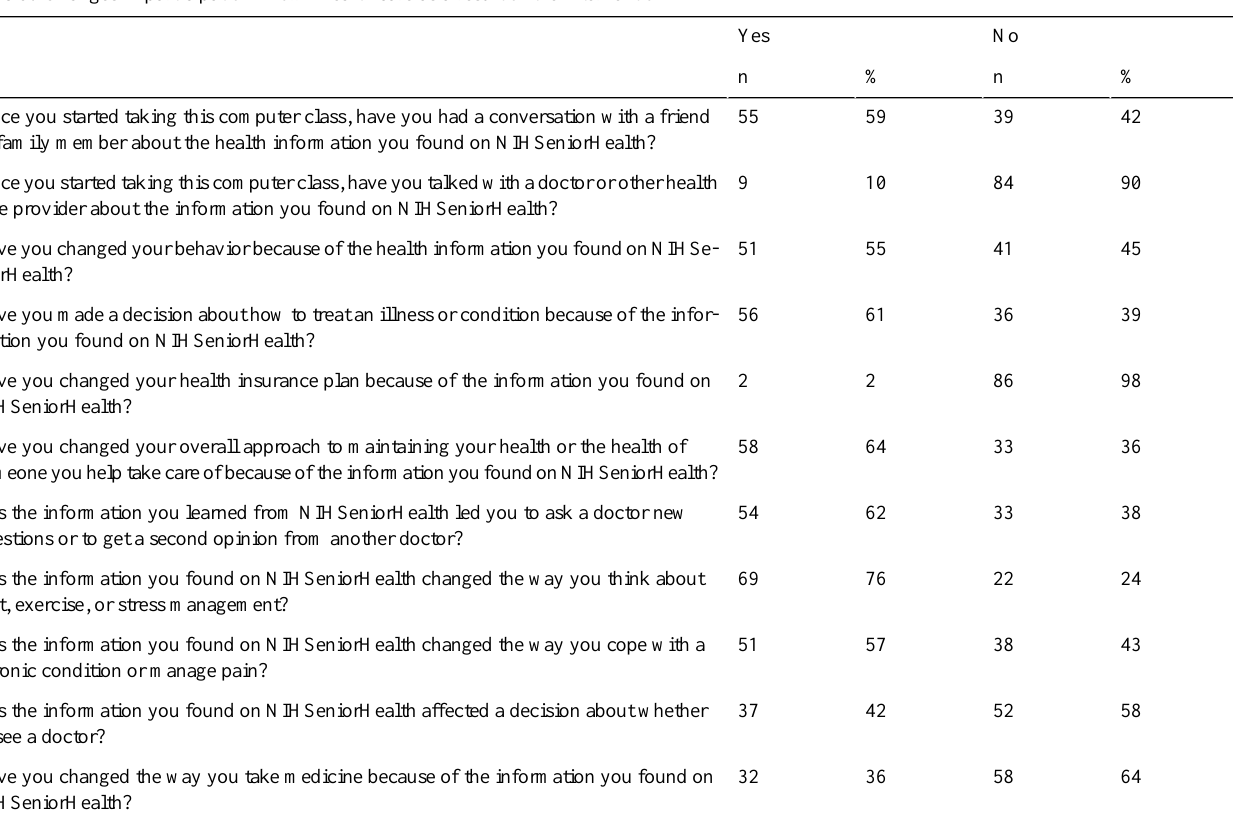
Table 6. Changes in participation in own health care as a result of the intervention